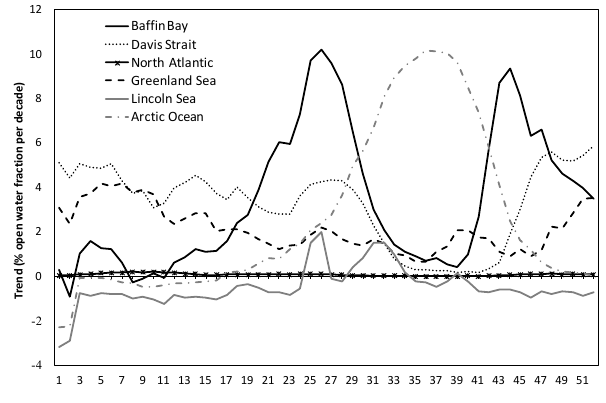
Figure 5. Trends in regional open-water fraction surrounding the Greenland ice sheet, computed from 1979 to 2014. Trends are com- puted using linear least squares.